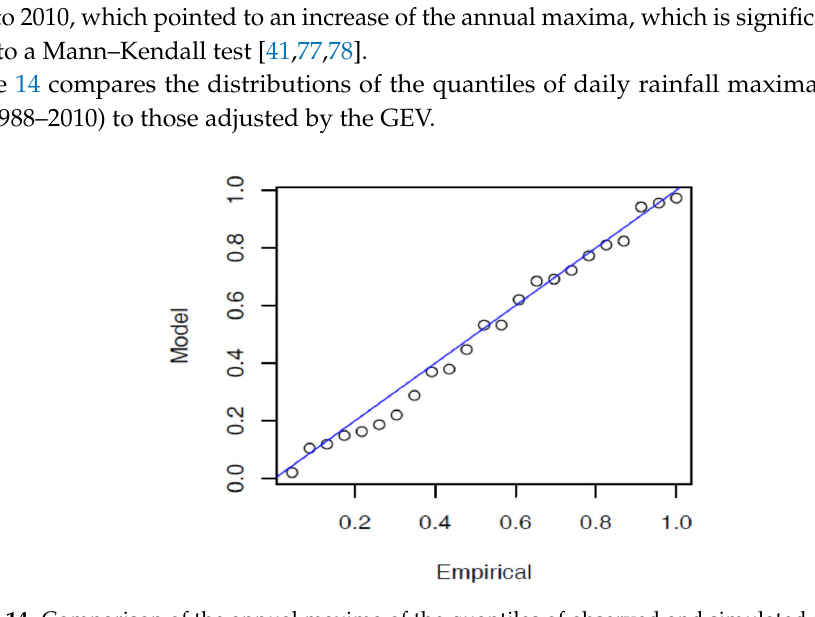
Figure 13. Interannual variation of the daily rainfall maxima from 1988 to 2010 in the Mono river basin at the outlet of Nangbéto.